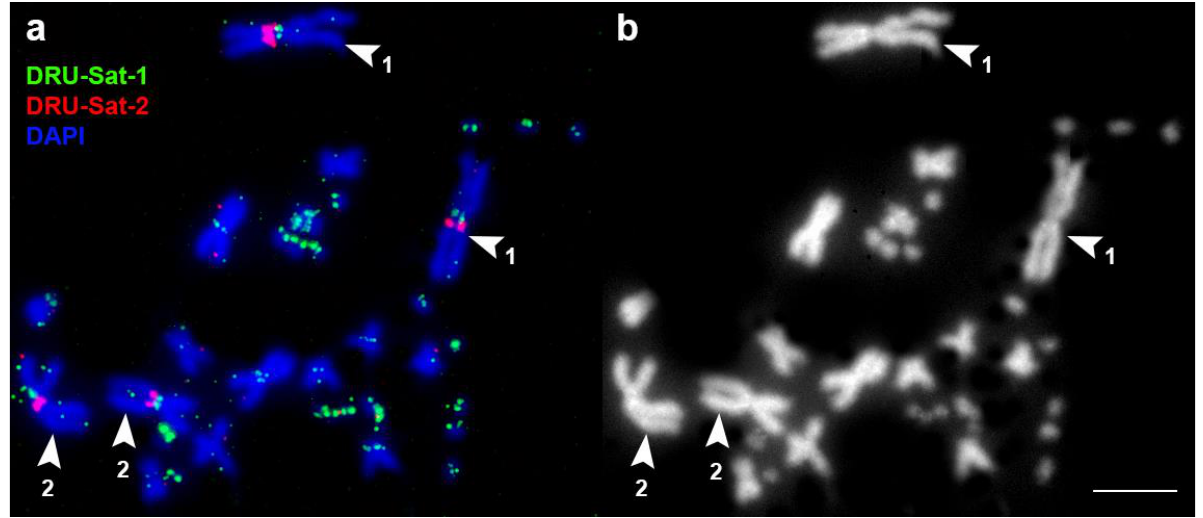
Figure 3. Localization of the satellites DRU-Sat-1 and DRU-Sat-2 in the chromosomes of D. russelii. 1: chromosome 1; 2: chromosome 2. ( a ) Merged image; ( b ) DAPI channel. Scale bar: 10 µ m.